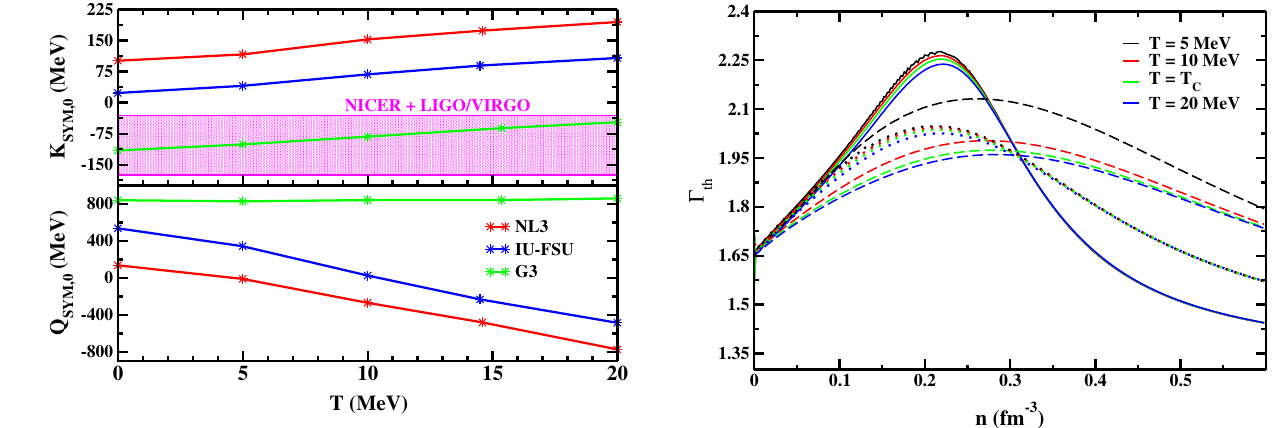
imum value of thermal index decrease which is